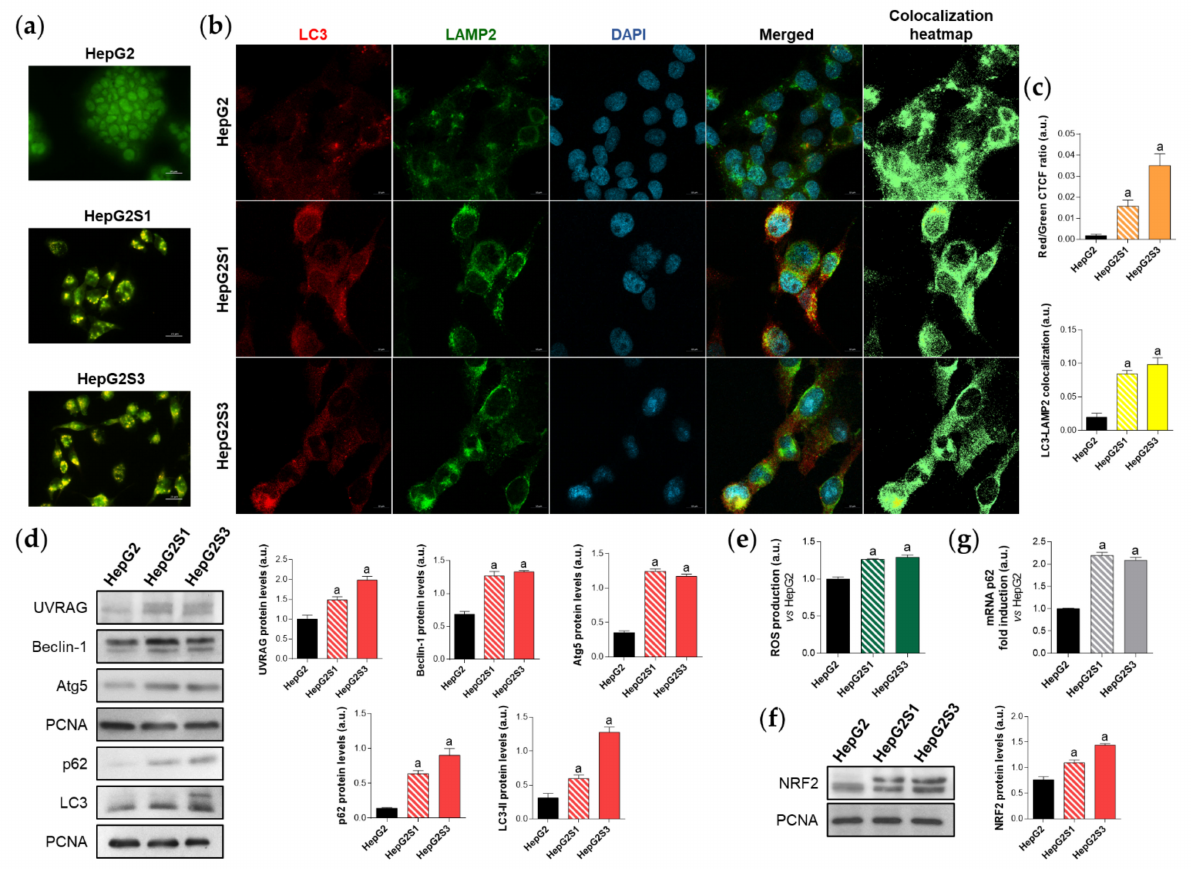
Figure 1. Comparison of basal autophagic status between HepG2S1 and HepG2S3 sorafenib-resistant lines and sorafenib- sensitive HepG2 parental cells. ( a ) Fluorescence microscopy images from acridine orange staining. Magnification 40 × , scale bar 25 µ m; ( b ) Confocal microscopy images from microtubule-associated protein 1 light chain 3 (LC3)-lysosomal associated membrane protein 2 (LAMP2) immunofluorescence. Red fluorescence, LC3. Green, LAMP2. Blue, cell nucleus. Yellow fluorescence in merged channel indicates LC3-LAMP2 colocalization. Magnification 63 × , scale bar 10 µ m. Corresponding LC3-LAMP2 colocalization heatmaps obtained using ImageJ are also shown; ( c ) Quantification of red/green corrected total cell fluorescence (CTCF) ratio from ( a ) and LC3-LAMP2 colocalization from ( b ), upper and lower bar graphs, respectively; ( d ) Representative immunoblots showing protein expression of several autophagy markers. Densitometry reading of each band (relative to the corresponding original proliferating cell nuclear antigen (PCNA) band) is shown; ( e ) Measurement of reactive oxygen species (ROS) production; ( f ) Immunoblots showing nuclear factor erythroid 2-like 2 (NRF2) protein levels. Densitometry reading of each band is shown; ( g ) Assessment of sequestosome 1 (p62) mRNA levels. Data from ( c – g ) are expressed as mean values of arbitrary units (a.u.) ± SD of three independent experiments. a p < 0.05 vs. HepG2